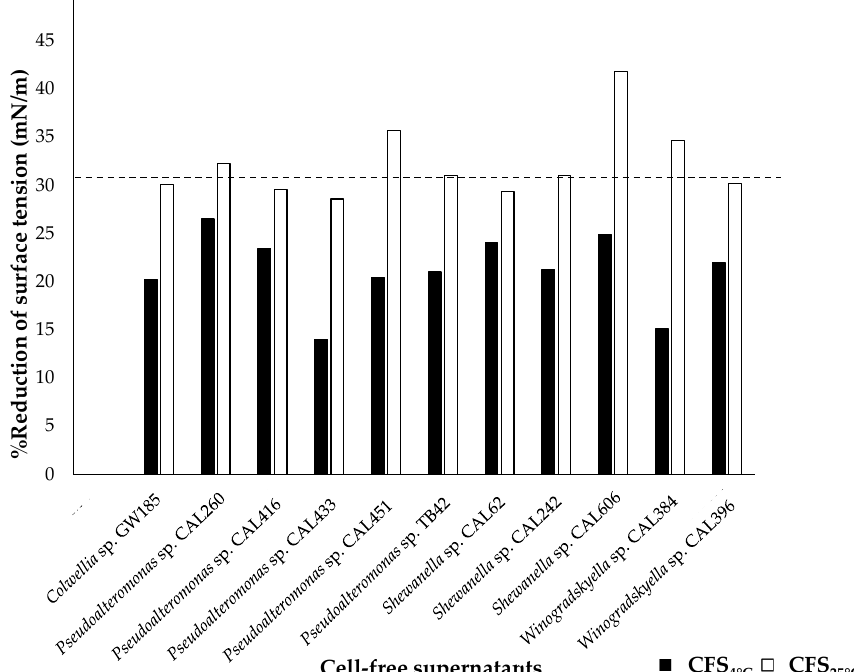
Figure 2. Reduction of the surface tension (ST) of water by CFSs 4°C and CFSs 25°C obtained from Antarctic sponges-associated bacteria. Reduction of ST was considered unaffected below 30% .